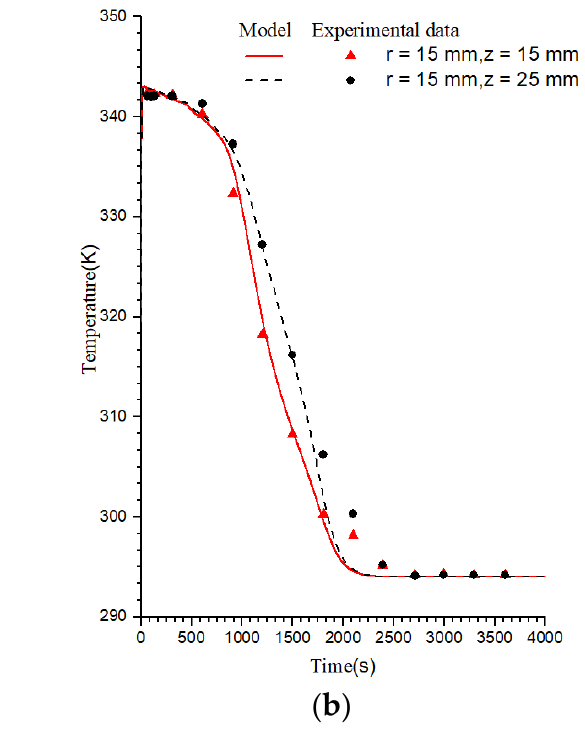
Figure 3. Comparison of calculated and measured results. ( a ) Temperature measuring points; ( b ) Simulation and experimental comparison.